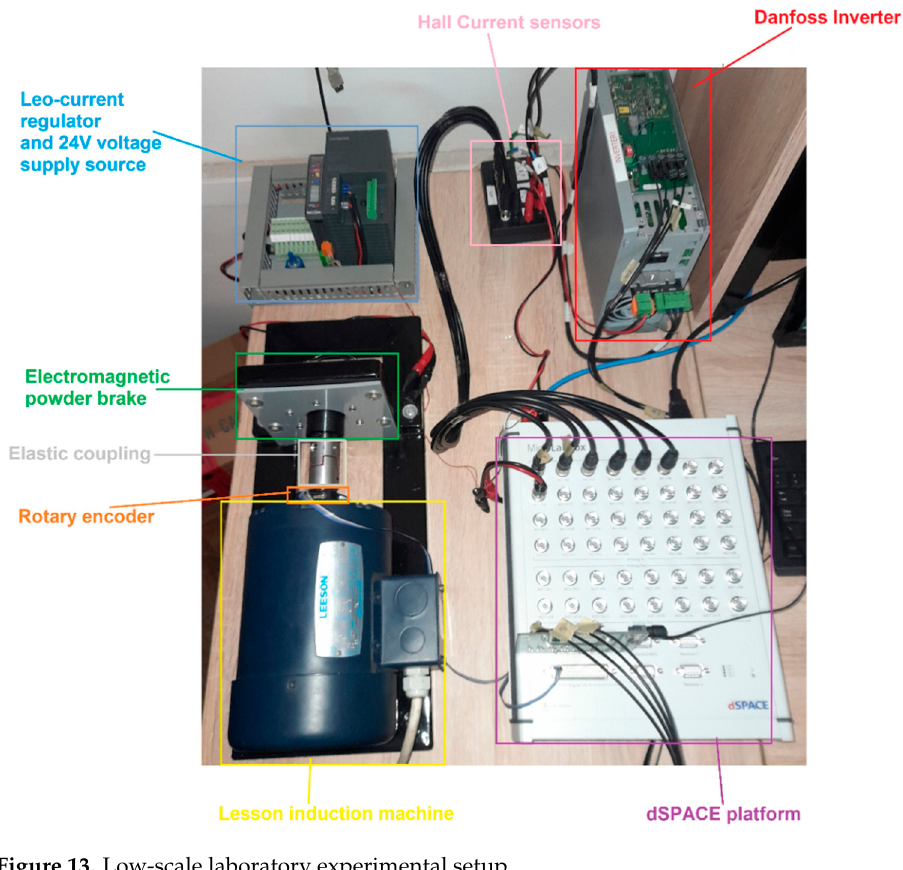
Figure 13. Low-scale laboratory experimental setup.